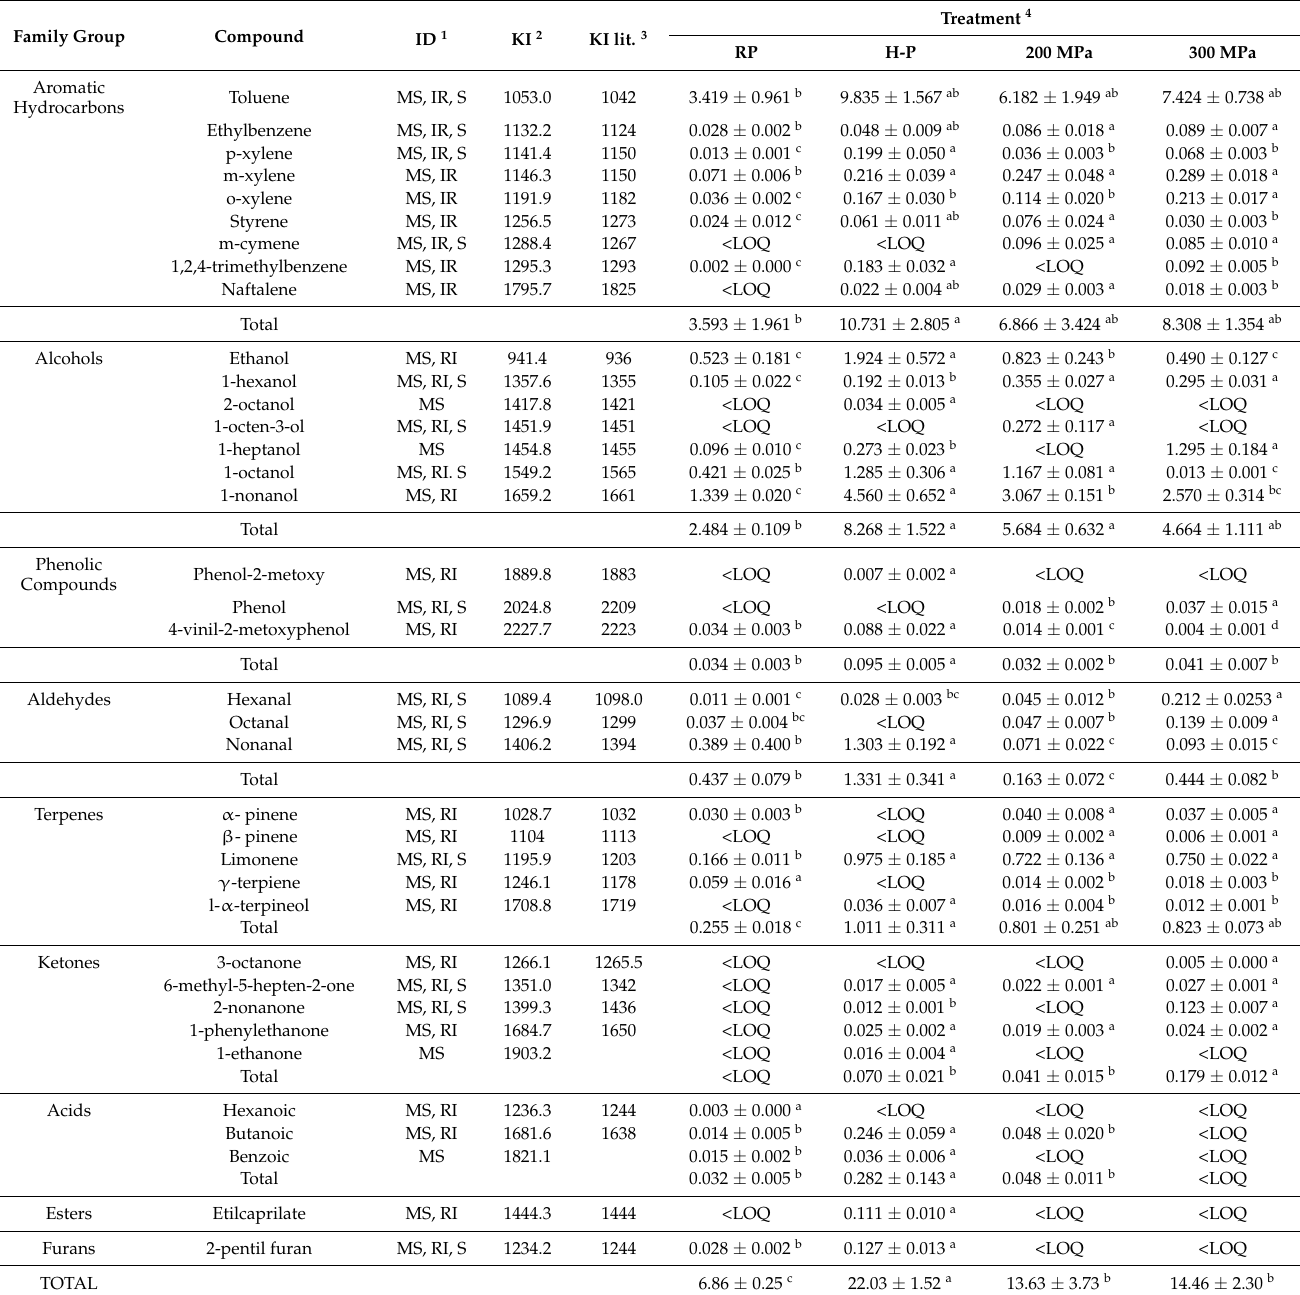
Table 1. Concentration of volatile compounds ( µ g of 4 methyl-2-pentanol/mL) in tiger nut beverages, grouped by their chemical